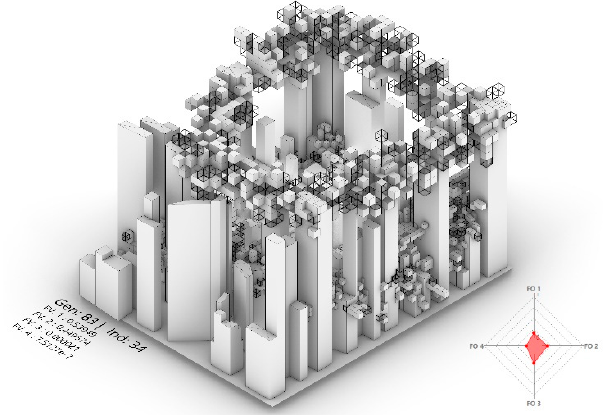
Figure 18. The ‘global compromise’ solution (solution closest to the ‘Utopia’ point) alongside its diamond chart.